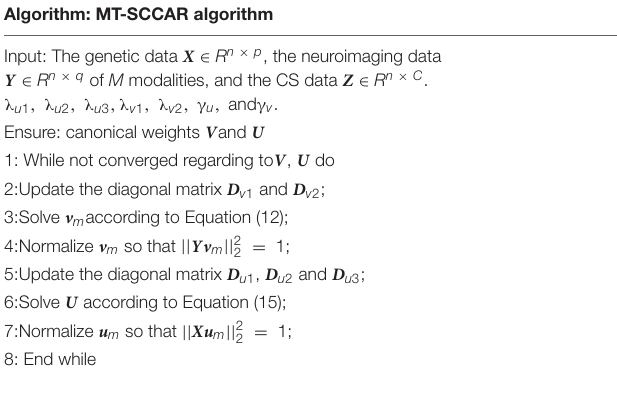
TABLE 2 | Specific procedure of MT-SCCAR